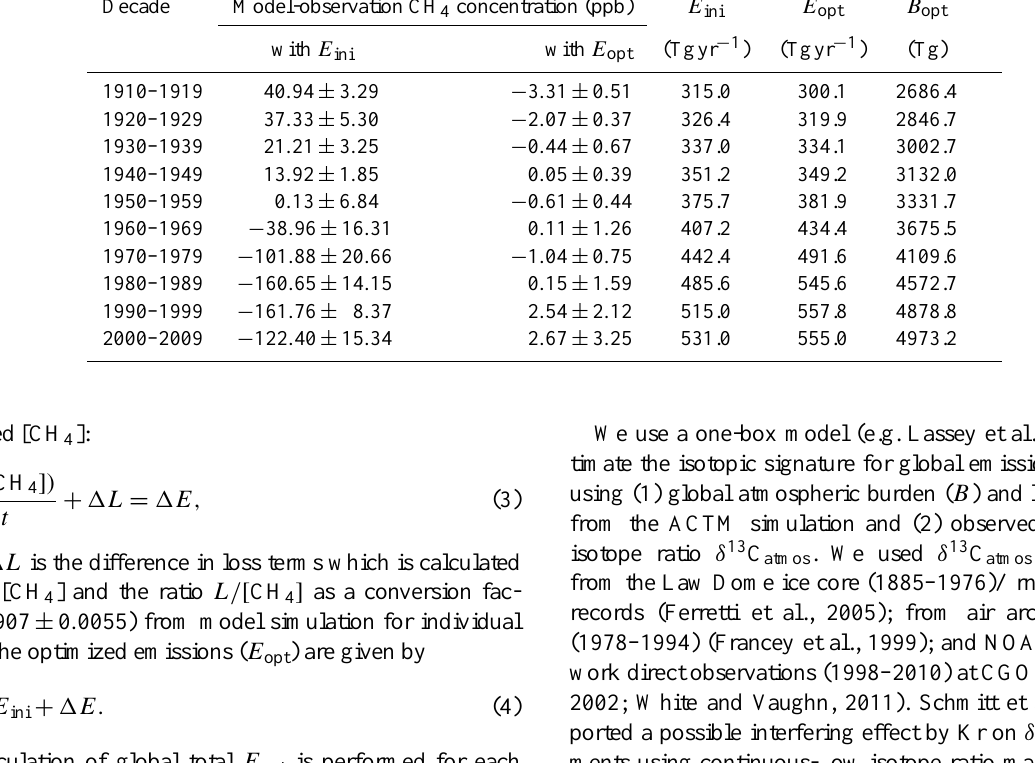
Table 2. Average bias and 1SD (in ppb) of model-observed CH 4 concentration for each decade over the Antarctic region. The averages of E ini , E opt and B opt for each decade are also shown. The annual mean values for all years are given in Table S2.